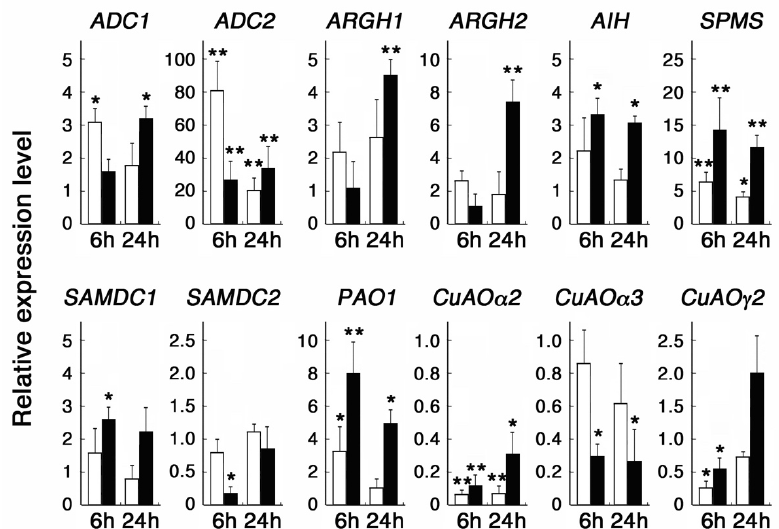
Figure 1. Effect of MeSA and NaSA on polyamine metabolic genes. Seven-day-old seedlings grown in liquid MS solution were further incubated with 1mM MeSA (white bars) or NaSA (black bars) for 6 and 24 h. Transcript levels relative to the control of no SA treatment are shown. Data are expressed as mean values ± SD ( n = 6). Asterisks indicate the statistical significance analyzed with Student’s t -test, (* p < 0.05, ** p < 0.01).